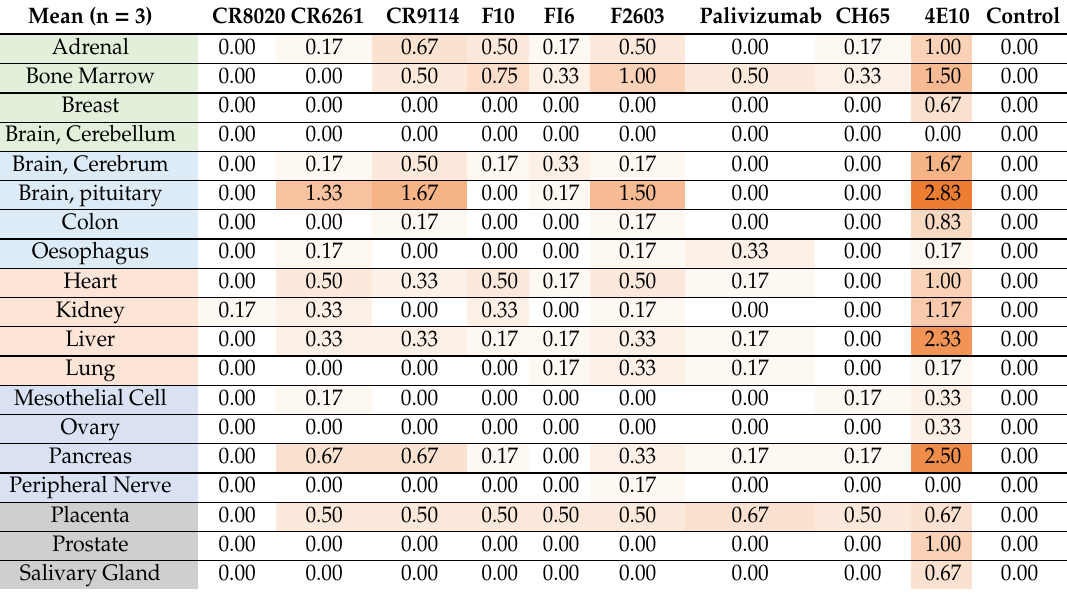
Table 1. Immunohistochemistry of MAbs on 30 Tissues